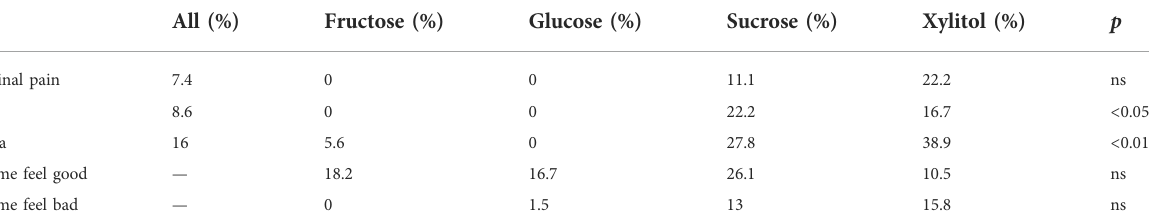
TABLE 4 Beverage tolerance and